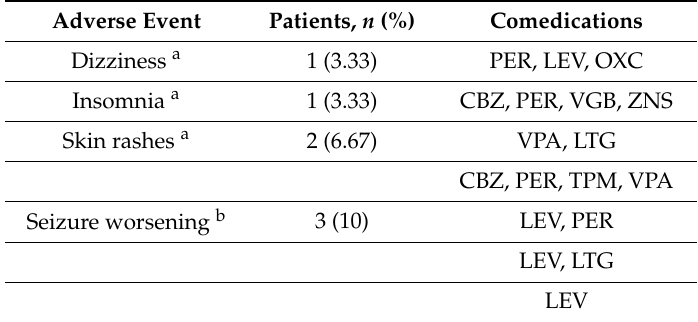
Table 7. Adverse events reported in the patients, including the three patients who discontinued. Adverse Event Patients, n (%)